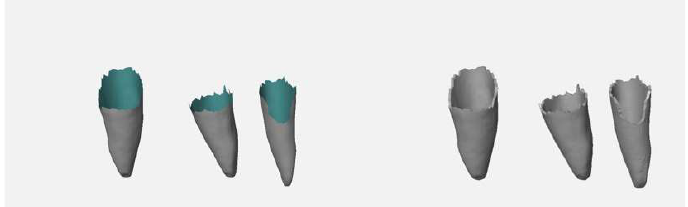
Figure 3. Meshes of the roots (rear faces of the meshes shown in blue-green) (left), extruded root surfaces representing the periodontal ligament (right).